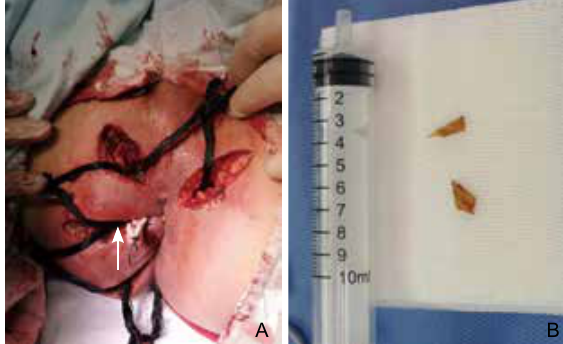
Figure 9 (A) The operative view of the anorectal abscess with the foreign body (arrow); (B) The removed chicken bone pieces was